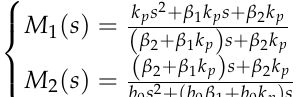
In order to facilitate the analysis of the LCCL grid-connected inverter system controlled by the first-order LADRC, the transfer function of the first-order LADRC system is obtained through the analysis, as shown in Equation (18).